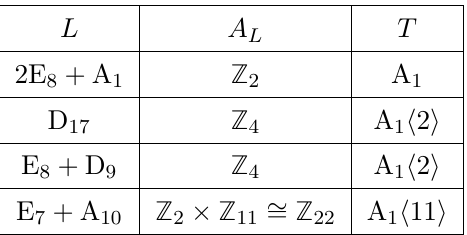
Table 1. Examples of allowed L with ‘ ( A L ) = 1, when d =